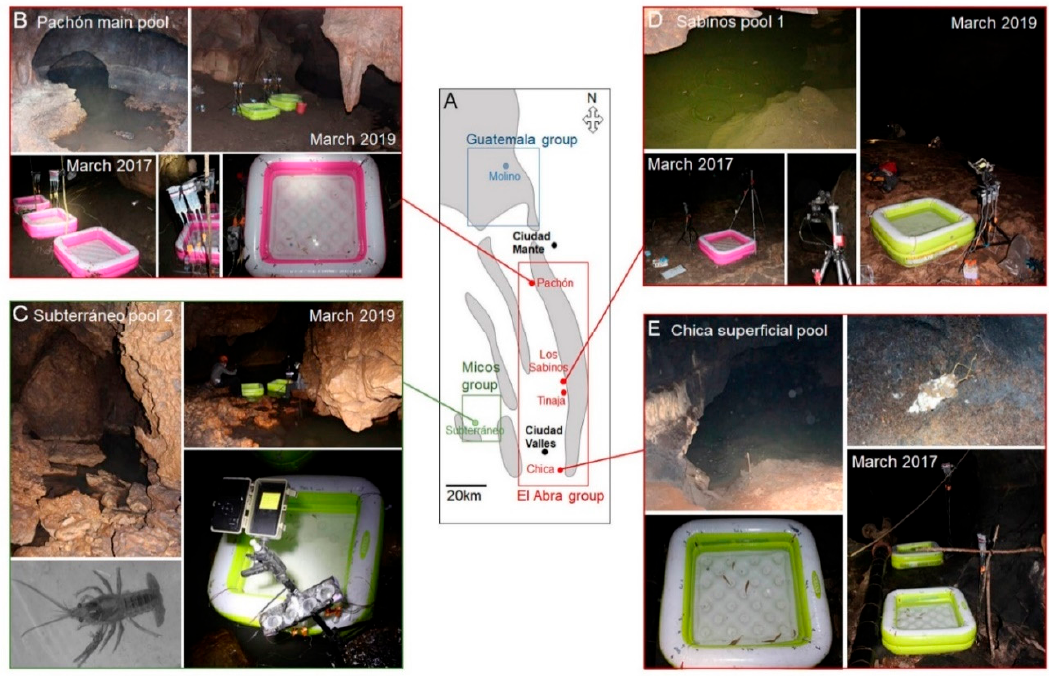
Figure 3. Cavefish sizes and phenotypes in di ff erent caves; ( A ) Sizes (left graph) and body mass Figure 3. Sampling cavefish olfactory skills in their natural environment; ( A ) Simplified map of the indexes (BMI, right graph) of the cavefish individuals tested for olfactory responses in the Pach ó n region of Ciudad Valles, Mexico. Mountain ranges are in grey. The locations of visited caves are (purple), Sabinos (brown), Subterr á neo (red), and Chica (grey) caves. Asterisks indicate significant indicated by colored circles. The color code indicates the geographical group where they belong; ( B ) di ff erences (Mann–Whitney test); ( B ) Comparison of sizes of the cavefish tested for olfactory responses Fieldwork in the Pachón cave. The main pool was muddy and the water level was low. Note that in in di ff erent field campaigns, in 2017 and 2019, showing that the condition of the fish tested did not March 2017 and March 2019, the three plastic pools were installed and processed in the best possible vary; ( C ) Comparison of sizes of cavefish in di ff erent water ponds in a same cave locality, showing that reproductive manner, on the “beach” along the main pool. Close-ups show the Luer-lock perfusion fish condition varied, probably due to local trophic, environmental and / or genetic parameters; ( D ) Fish system and the eight fish installed in one of the experimental plastic pools; ( C ) Work in pool 2 of the phenotypes are fully troglomorphic in the Pach ó n and Sabinos caves, whereas hybrid-type fish with Subterráneo cave, located just after the 3-m pit. This pool offers a rocky substrate. There, we small eyes (arrowheads) and some pigmentation can be seen in Subterraneo (pool 2) and Chica repeatedly observed the presence of crayfishes (predators on adult cavefish). The bottom right panel (superficial pool) caves. They result from hybridization with introgressed surface fish. Of note, shows the infrared, hunting-type camera, used in our 2019 campaign; ( D ) Work in Los Sabinos cave. in Subterraneo, surface fish enter by the cave entrance at the polje level, whereas, in Chica, surface fish Pool 1 of this cave had crystal-clear water. Again, note that olfactory setups were installed in the same enter the cave by the bottom. Hence, in both caves, the most troglomorphic fish are place in March 2017 and 2019, respectively, i.e., on a rocky plateau just above pool 1. A close-up shows the Raspberry Pi camera used during our 2017 campaign. ( E ) Testing olfaction on fish from the Chica superficial pool. The top photos show the guano slope leading to the superficial pool, which was very rich in organic material (decomposing bat cadaver). On the bottom left panel, note the large size of the eight fish (compare with the equivalent picture in Pachón, and see Figure 4).